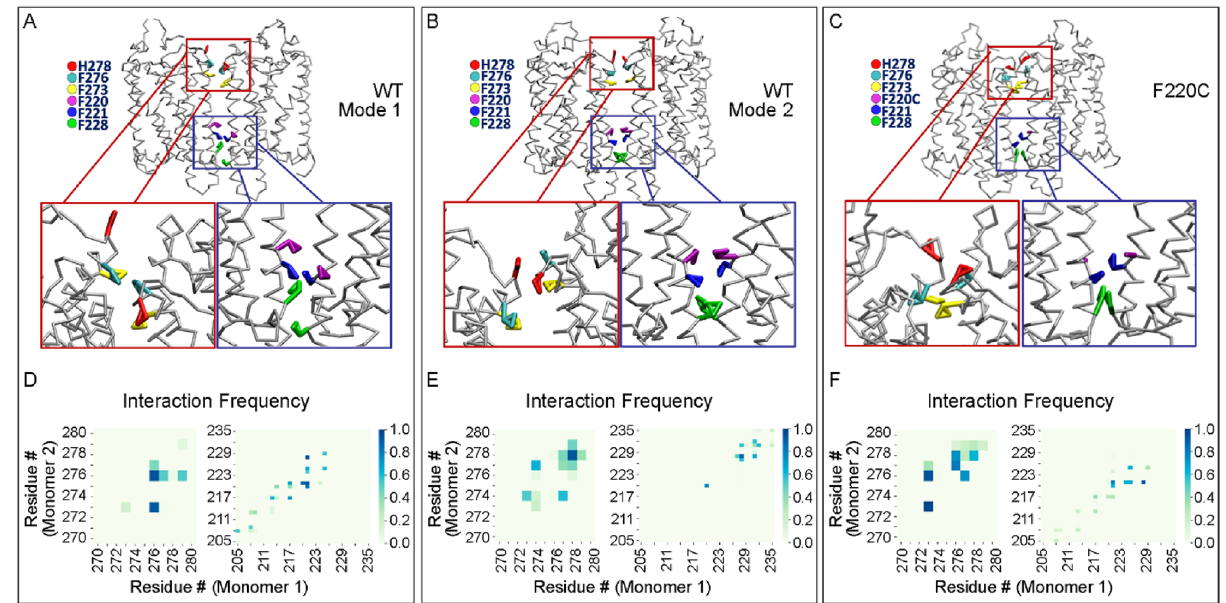
Figure 5. Modes of dimerization of the WT and F220C opsin. ( A–C ) Structural snapshots corresponding to the modes of dimerization of the WT (Modes 1 and 2 shown in A , B respectively) and F220C (C) opsin constructs from the CG MD simulations. Insets in red and blue rectangles show magnified views of interactions between pairs of TM6 and TM5 residues, respectively. Key residues participating in the interactions (H278 6.61 , F276 6.59 , F273 6.56 in TM6 and F220 5.55 , F221 5.56 , F228 5.63 in TM5) are depicted in different colors and are labeled. ( D–F ) Pairwise contact frequencies between residues on TM5 (right columns) and TM6 (left columns) in the dimerization modes shown in panels ( A–C )